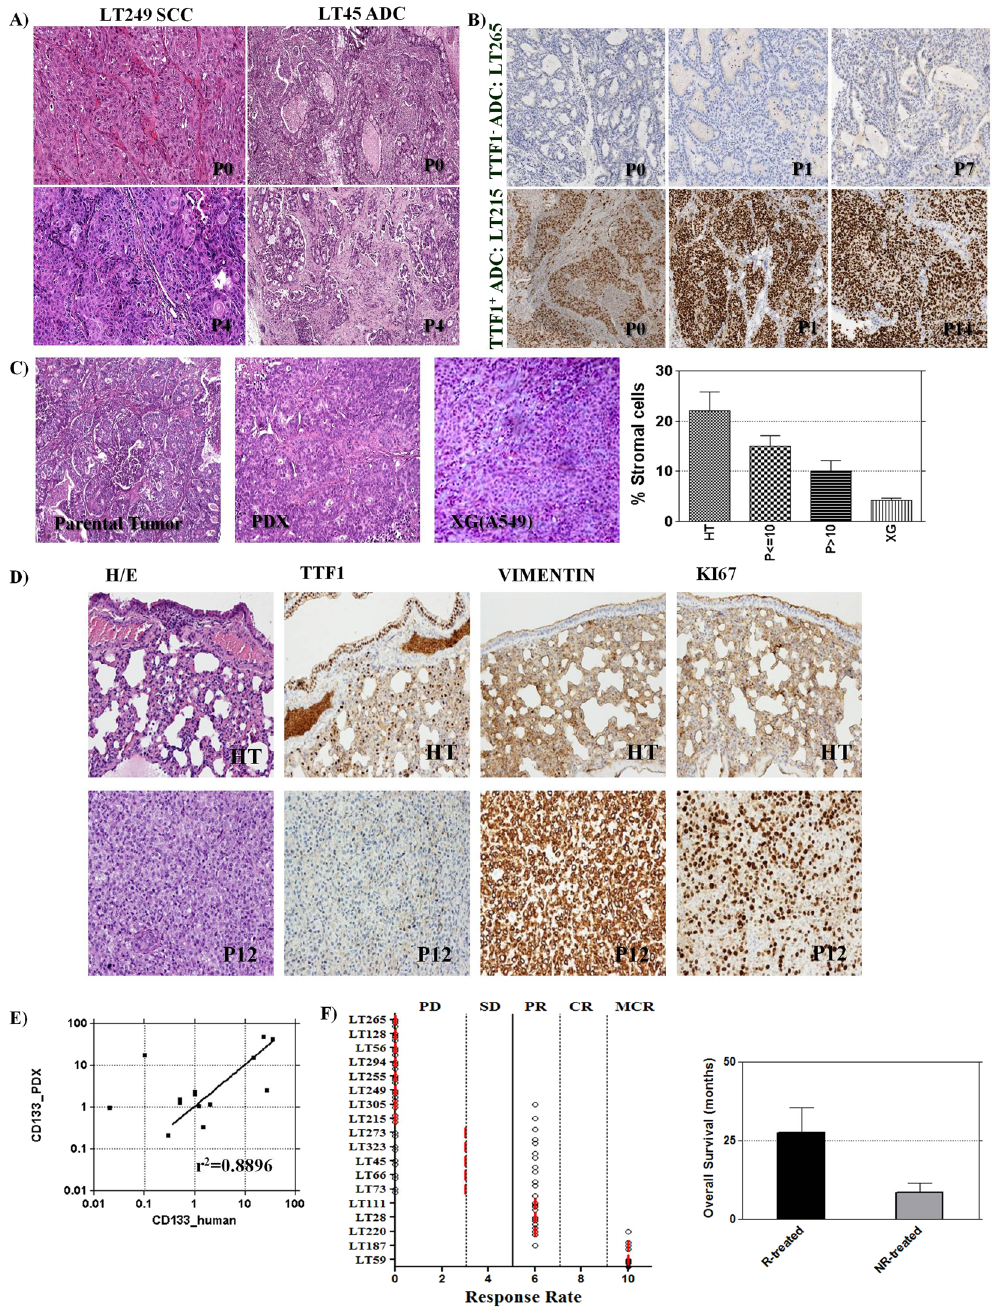
Figure 1. Analysis of PDXs characteristics. ( A ) Parental tumour diagnosis was maintained in all established PDX. Pictures show a representative example of 1 ACC- and 1 SCC-derived PDXs. ( B ) Immunohistochemistry markers analysis confirmed that our PDXs platform generally maintained the same expression pattern of parental tumours, picture shows a representative example of a TTF1 expressing ADC-derived PDX. ( C ) PDXs stromal content was generally lower compared to parental tumours, especially at P > 10. However, stromal components were always more represented in PDXs than in cell line derived xenografts (average stromal component: 22 ± 12% in parental tumours, 15 ± 7% in P ≤ 10 and 10 ± 7% in P > 10, n = 10; 4.2 ± 1.012% in lung cancer cell line xenografts, n = 5). ( D ) In PDX LT220 complete loss of TTF1 and marked acquisition of vimentin and Ki67 labelling index was observed along with the appearance of spindle cells. ADC = Adenocarcinoma, SCC = Squamous Cell; ( E ) CD133 + cell percentage was also maintained in PDX models (n = 17, p = 0.0005, r 2 = 0.568); ( F ) PDXs were differently responsive to cisplatin treatment (5 mg/Kg once a week for three weeks), models were considered responsive when at least a partial response (PR, median of four tumors) was reached. Mean Overall Survival of patients treated after surgery and from whom a responsive PDX was derived (R-treated) were higher than that of patients from whom a non responsive PDX was derived (NR-treated; 27.667 ± 7.753 months n = 3 and 8.5 ± 3.019 months n = 6, respectively). MCR: maintained complete response; CR: complete response; PR: partial response; SD: stable disease; PD: progression of